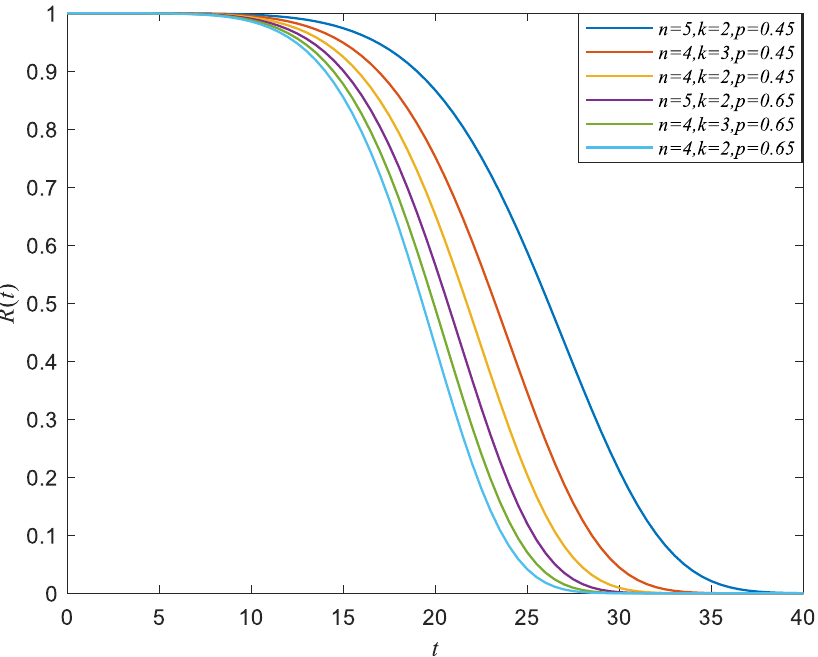
Figure 5. Simulation result of the system reliability under trigger mechanism 2.